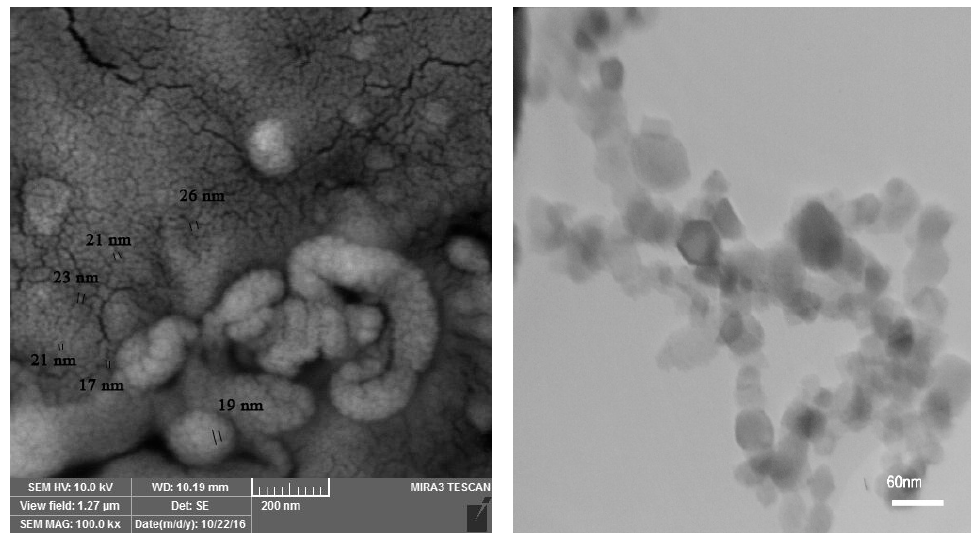
Figure 1. Transmission electron microscopy (TEM; Left ) and scanning electron microscope (SEM; Right ) images of Se-NPs .